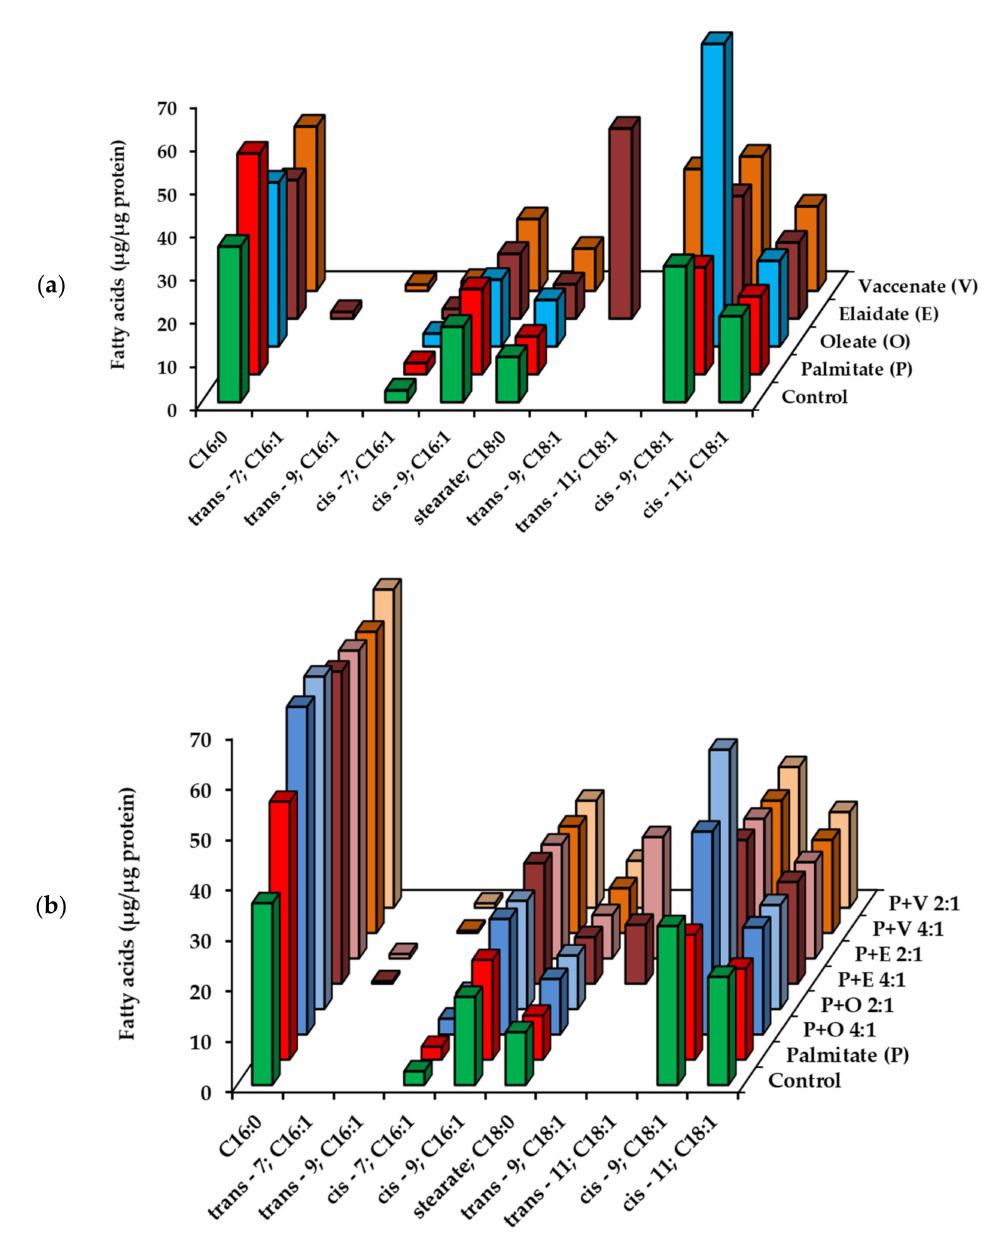
Figure 2. Fatty acid profile of HepG2 cells treated with fatty acids at sub-toxic concentrations. Cells were treated with ( a ) BSA-conjugated palmitate, oleate, elaidate or vaccenate (50 µ M) or with ( b ) palmitate (50 µ M) and oleate, elaidate or vaccenate at a 4:1 or 2:1 molar ratio (12.5 or 25 µ M) at 70–80% confluence for 8 h. The amount of relevant fatty acids was measured in the cell samples by GC-FID after saponification and methylation. Data were normalized to the total protein content of the samples and are shown as mean values of at least four independent experiments (see the mean and S.D. values in Table